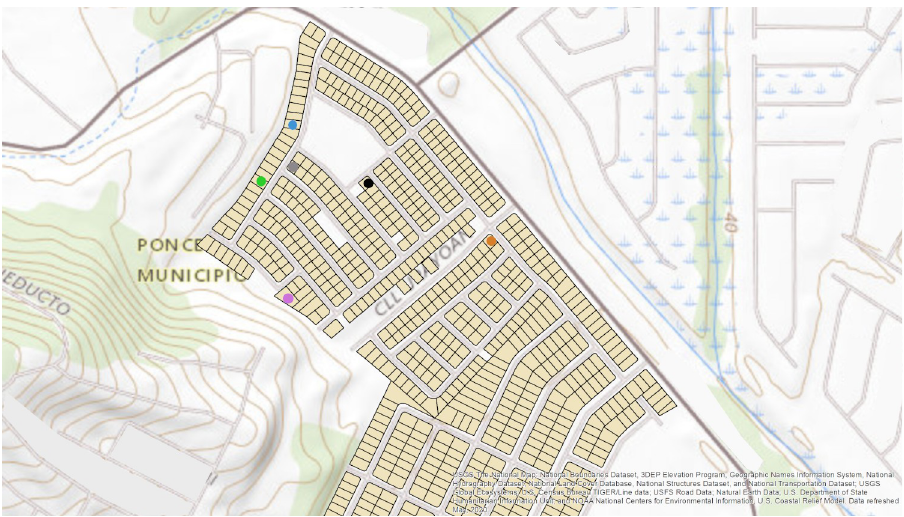
Fig 2. Representation of HTrack’s main map and navigation area. This map recreates how HTrack’s main map is seen upon usage. Street names have been removed to protect participant privacy.